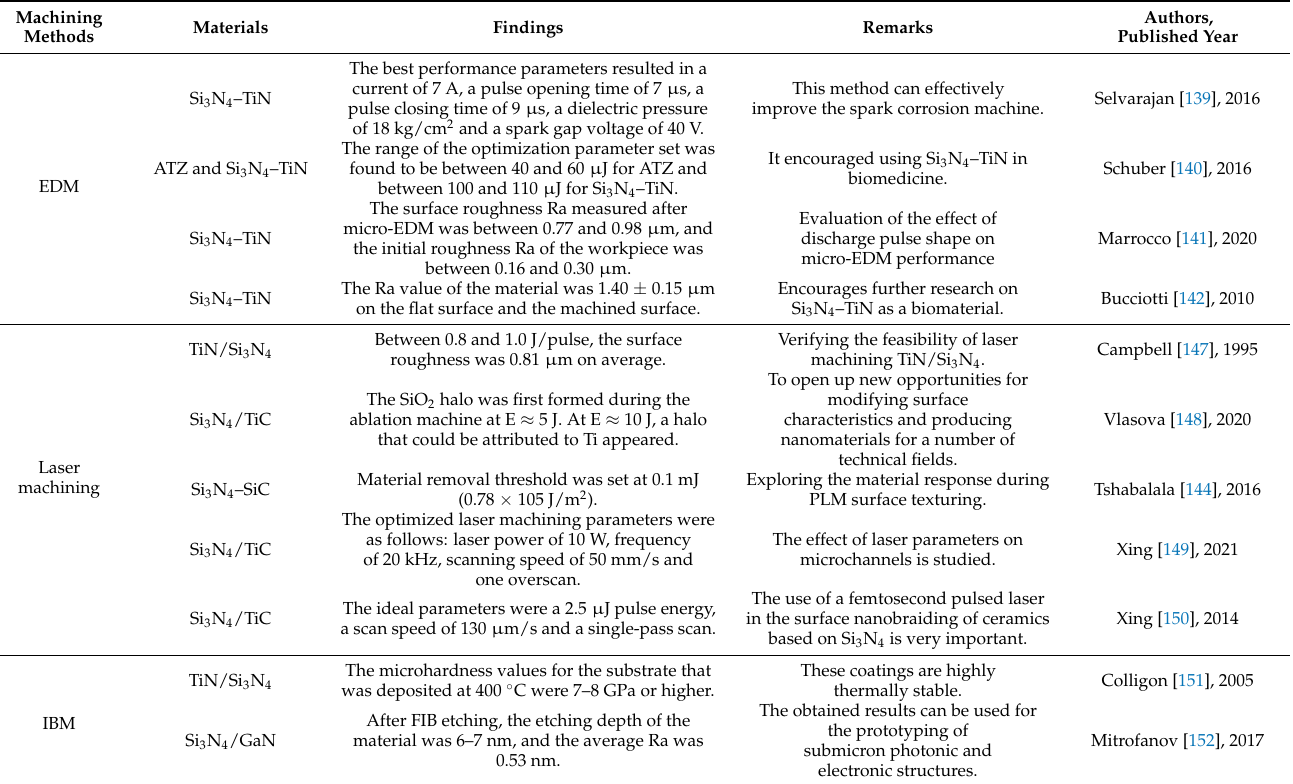
Table 3. Machining performance of nitride-based UHTCMCs.